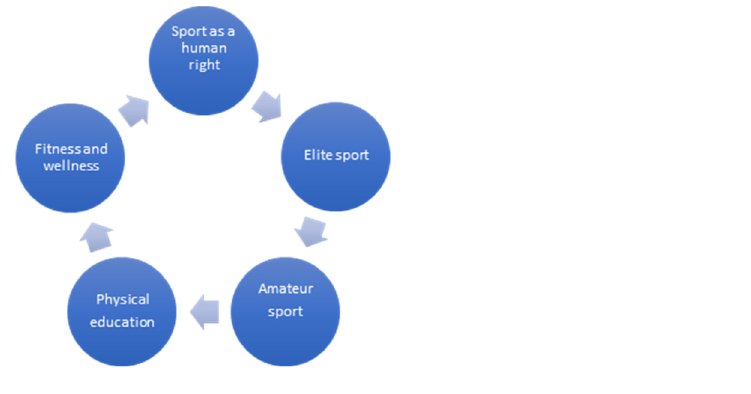
Figure 1. The interrelation between sport activities under the recognition as a human right